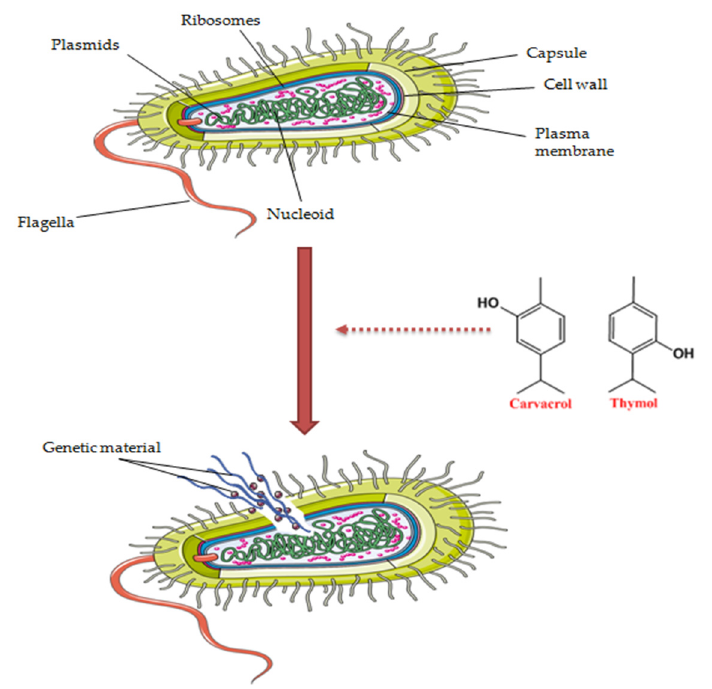
Figure 3. A snapshot of the antimicrobial mechanism of action of OvEo. Most bacterial skin and soft tissue infections occur due to infection with S. aureus , a Gram-positive bacterium whose toxins lead to the production of proinflammatory cytokines and mediators and an overall inflammatory response of the organism [70]. Infection with S. aureus can affect the superficial layer of the skin with the production of impetigo or infected abrasions, as well as the subcutaneous tissue or the dermis of the skin, leading to complicated skin infections (cellulitis, furunculosis, folliculitis, abscesses, wounds and ulcerations) [71]. Furthermore, methicillin-resistant S. aureus (MRSA) strains represent